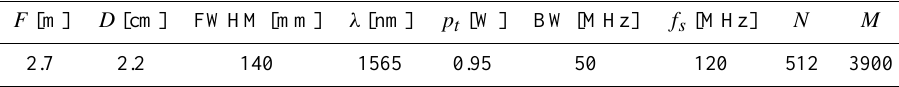
Table 1. Measurement campaign system parameters. p t , BW, and f s represent the optical output power, detection bandwidth, and sampling frequency, respectively. Furthermore, N and M represent the number of discrete Fourier transform (DFT) points and spectral averaging, respectively. Periodograms (Hayes, 1996) were used for the estimation of spectra as elaborated in Abari et al. (2014).